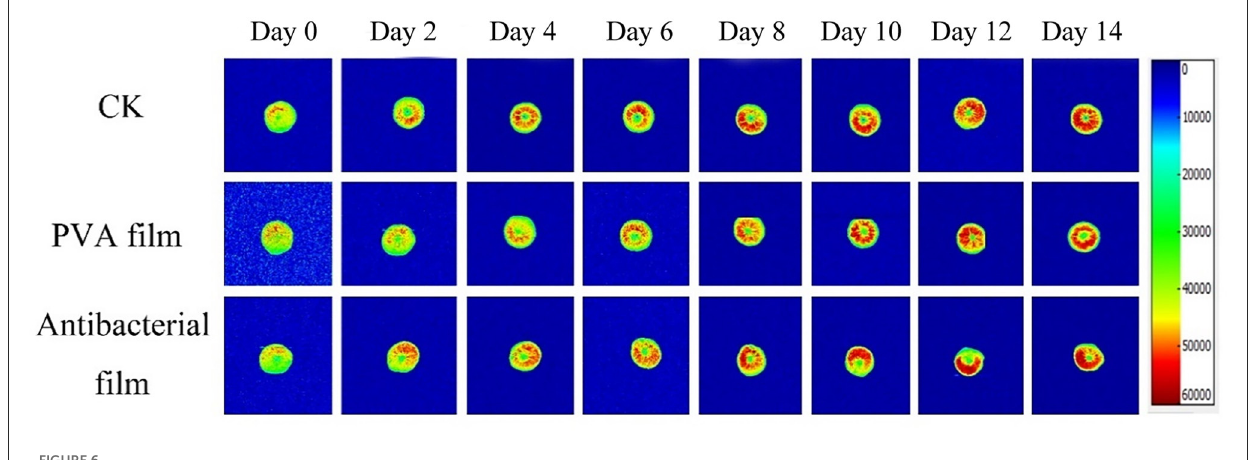
FIGURE6 Pseudo-color image of blueberry MRI.